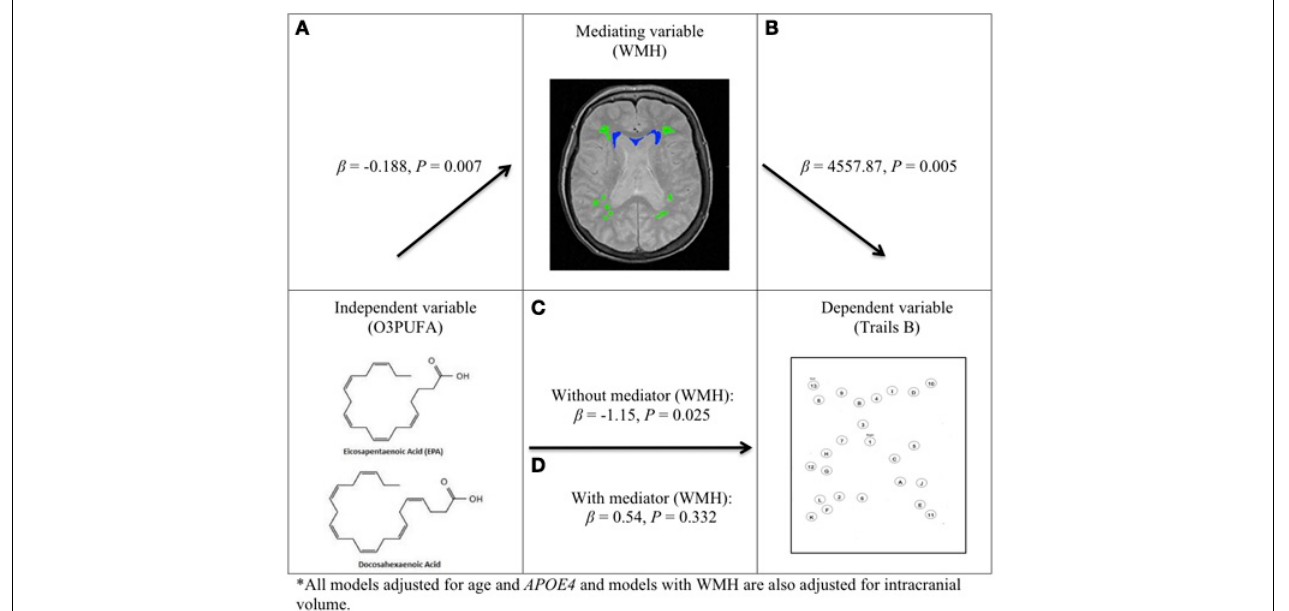
FIGURE 2 | O3PUFA and white matter mediated executive function in older adults ( n = 32). All models adjusted for age and APOE4 , and models with WMH also adjusted for total intracranial volume. (A) Higher O3PUFA and less white matter hyper-intensities (WMH) highlighted in green (subcortical deep) and blue (periventricular). (B) Higher WMH and